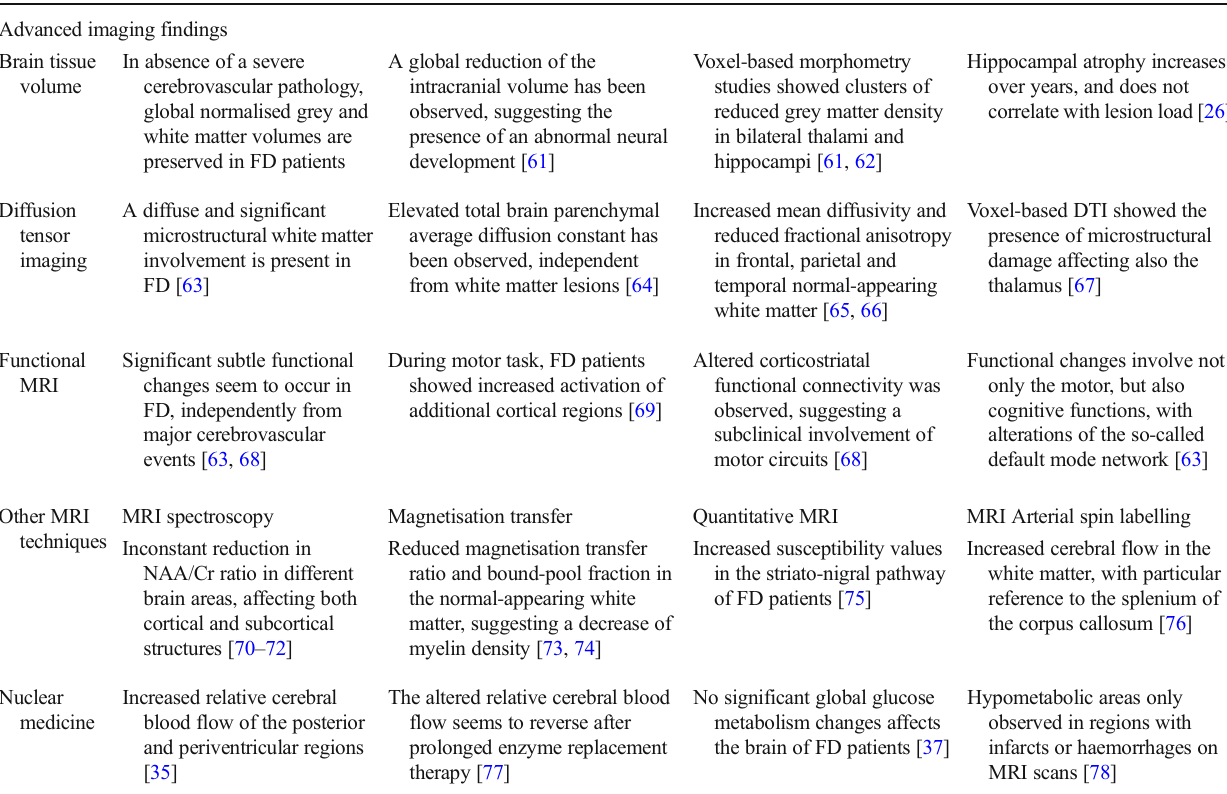
The major advanced imaging findings in Fabry disease Advanced imaging findings Brain tissue